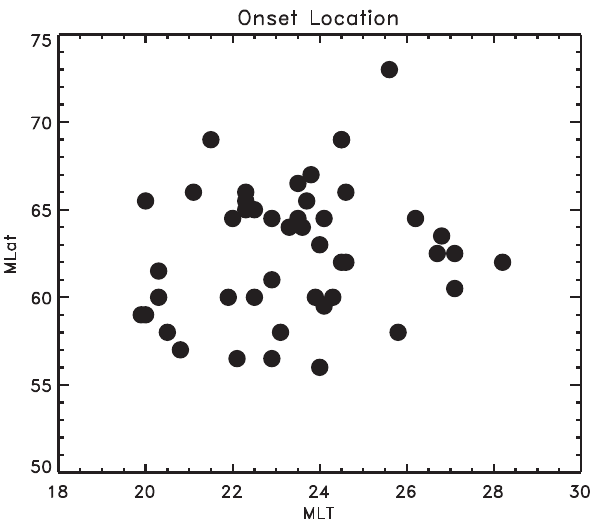
Fig. 4a. Locations in MLT/ILat coordinates of onsets for storm- time substorms having localized onsets.